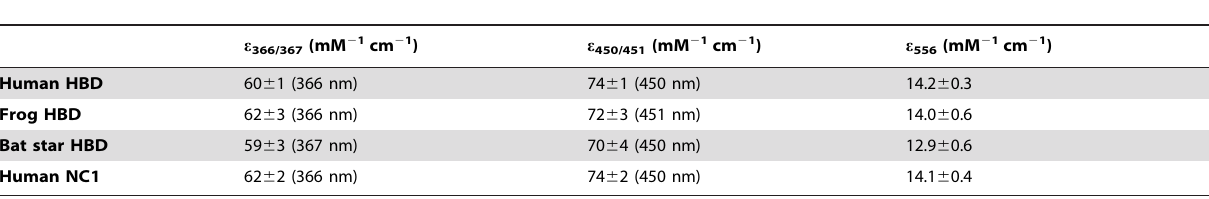
Table 1. Extinction coefficients for homologous